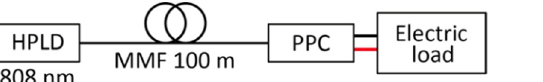
Figure 7. Experimental setup for O/E conversion performance measurement of PPC.